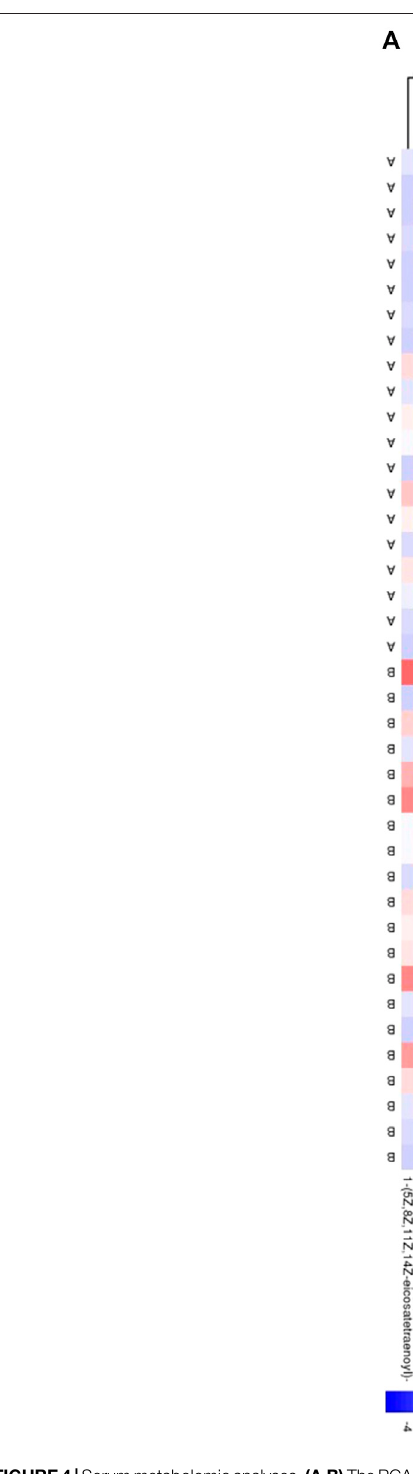
Frontiers in Genetics |